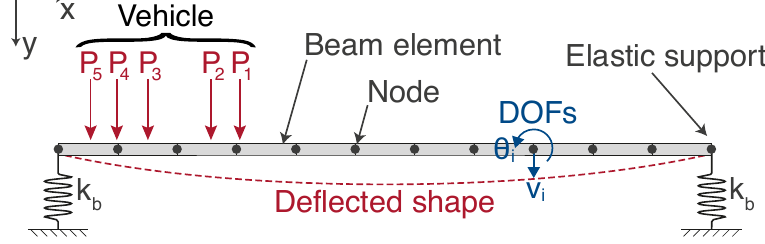
Figure 2. Sketch of 2D discretised bridge model used.